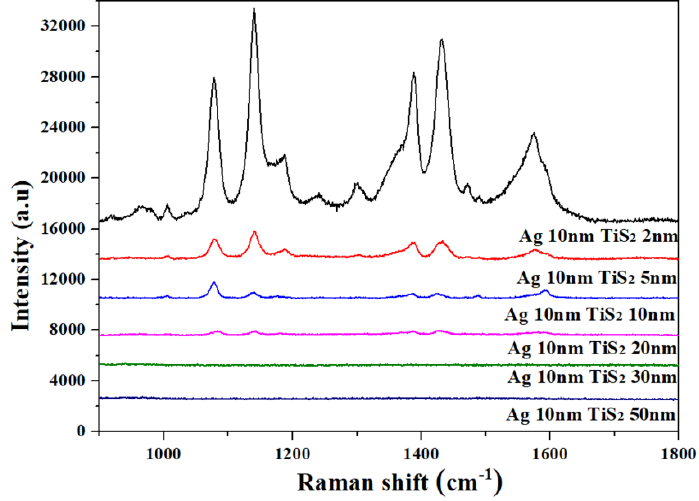
Figure 9. SERS spectra of Ag 10 nm/TiS 2 (t = 2, 5, 10, 20, 30, 60 nm) nanostructures on PS.